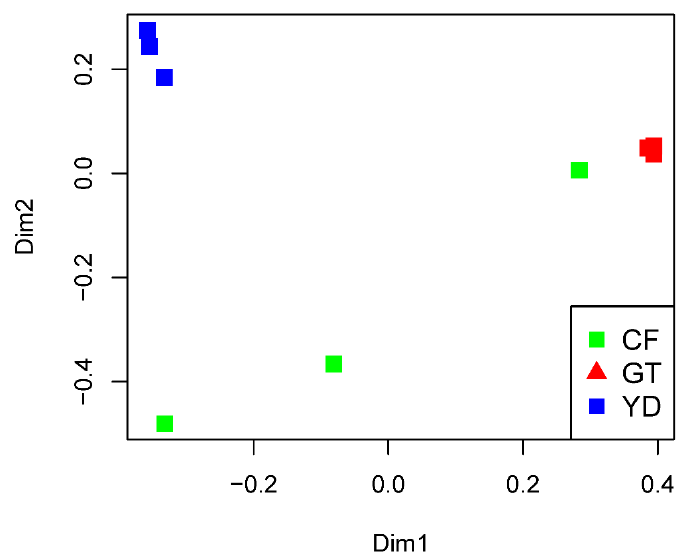
Figure 2. PCoA plot showing Bray – Curtis dissimilarities between the studied samples. GT: G. tokunagai ; CF: C. flaviplumus ; YD: Yeon Deung water.